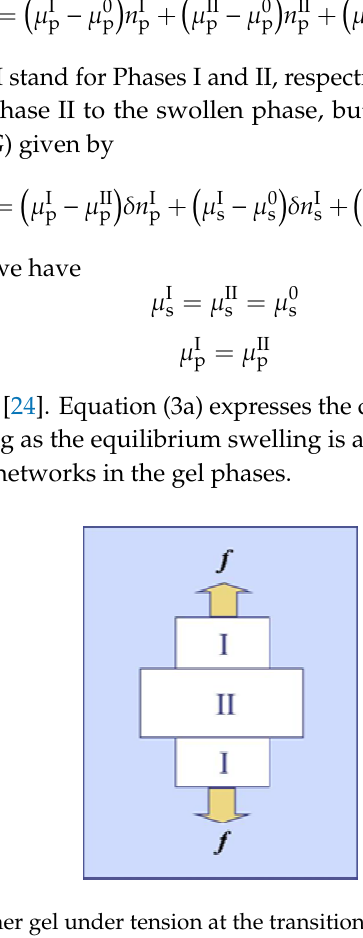
Figure 1. Cylindrical polymer gel under tension at the transition point. Two gel phases (I and II) and an outside solvent coexist. The upper and lower regions specified by I are the same.